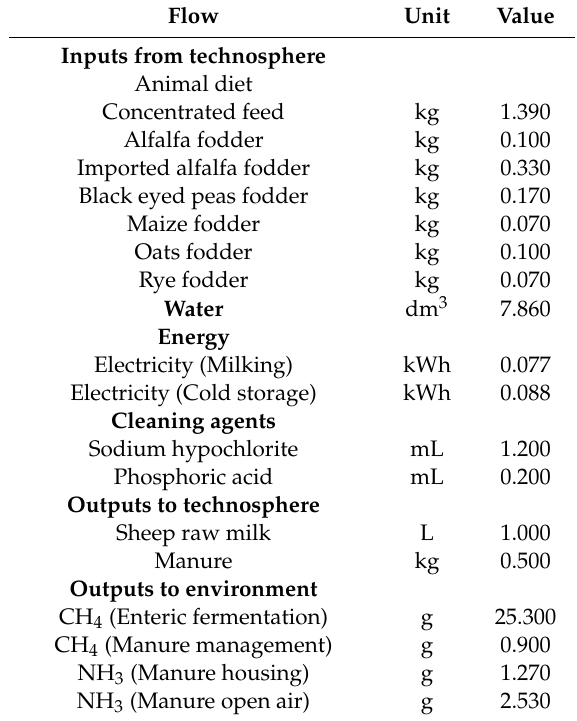
Figure 3. Inventory from both main systems, dairy farm and dairy factory. Table 1. Inventory data of 1 L raw sheep milk produced in the dairy